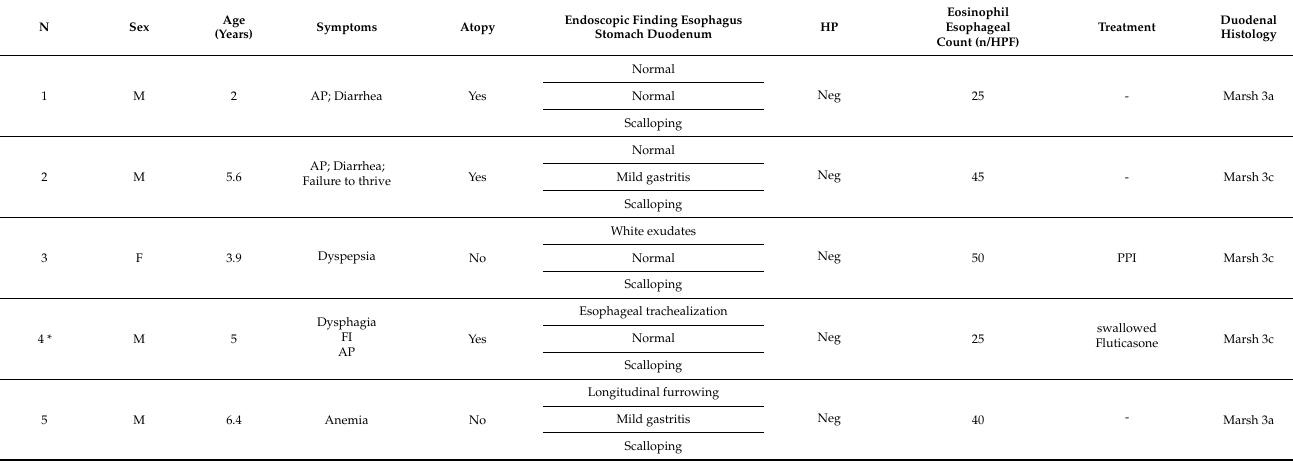
Table 1. Clinical presentation, endoscopic and histological findings of children with celiac disease and esophageal eosinophilia/eosinophilic esophagitis.